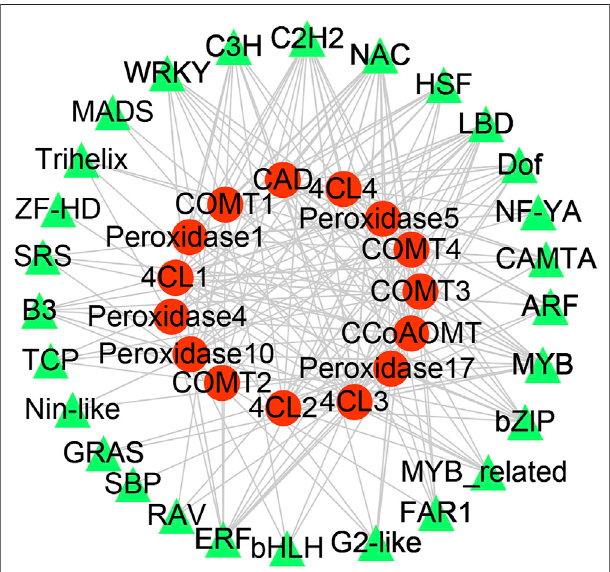
FIGURE 5 | Transcription factor-gene network in rubber tree lignin biosynthesis. Red circles represent genes and green triangles represent transcription